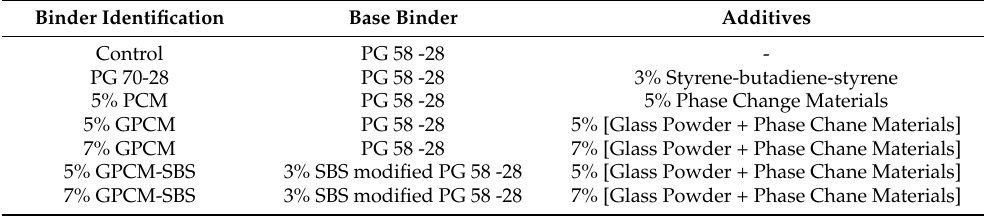
Figure 6. A schematic flow chart of asphalt binder preparation. Table 3. Nomenclature for asphalt binders .